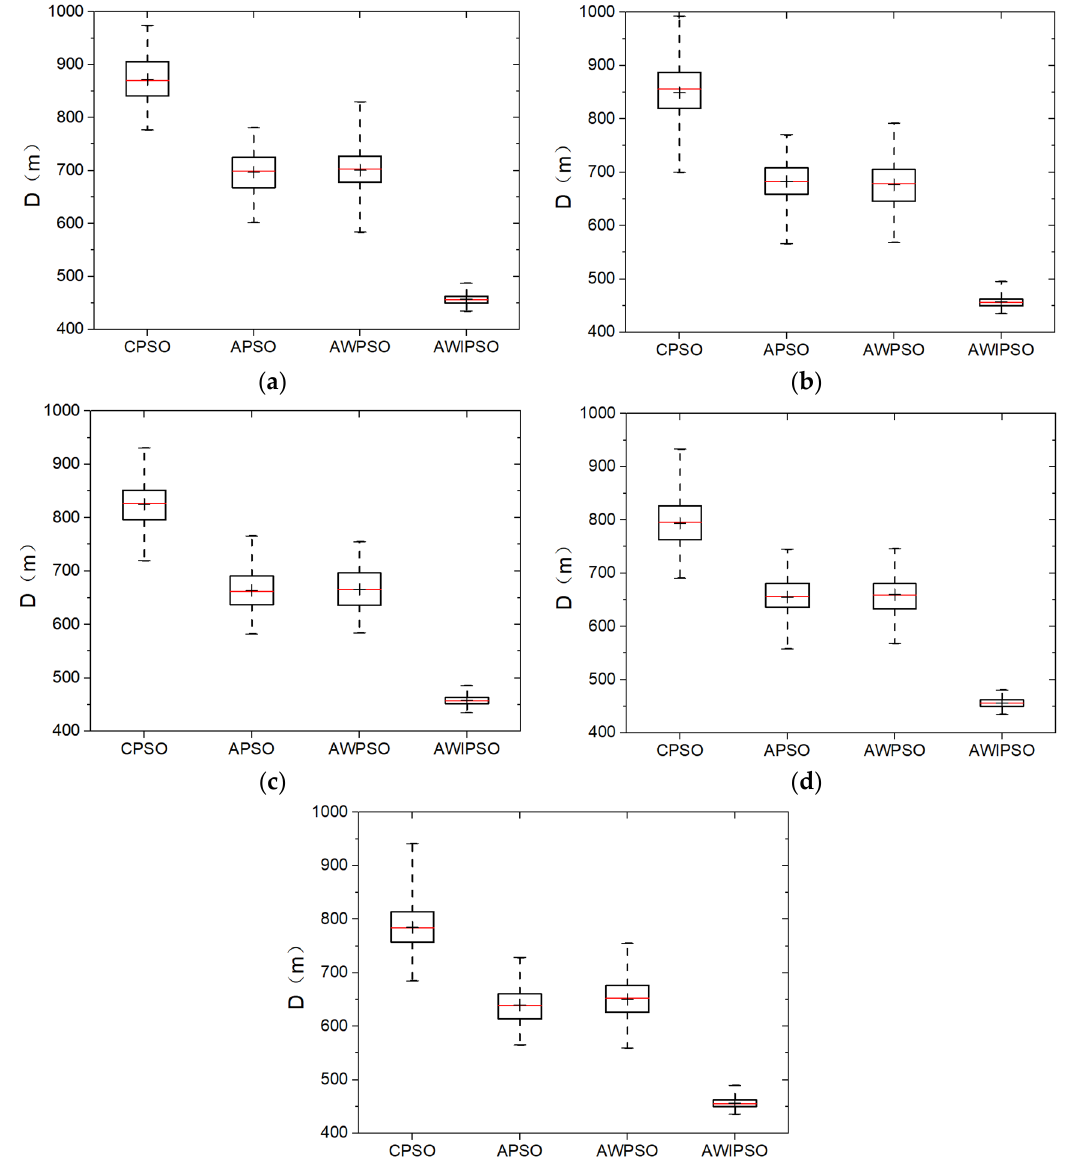
Figure 3. Solution distribution of each algorithm with five population sizes: ( a ) R = 300; ( b ) R = 400; ( c ) R = 500; ( d ) R =600; ( e ) R =700. Table 3. Statistical results of optimal path distance in 100 runs with five swarm sizes.